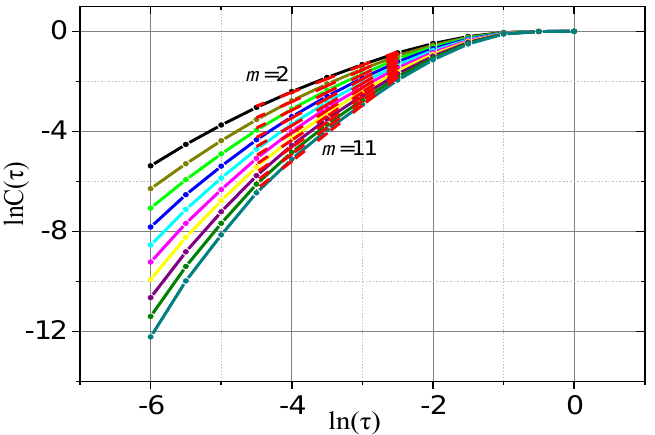
Figure 8. Relation curve between ln C ( τ ) and ln ( τ ) for the square target.